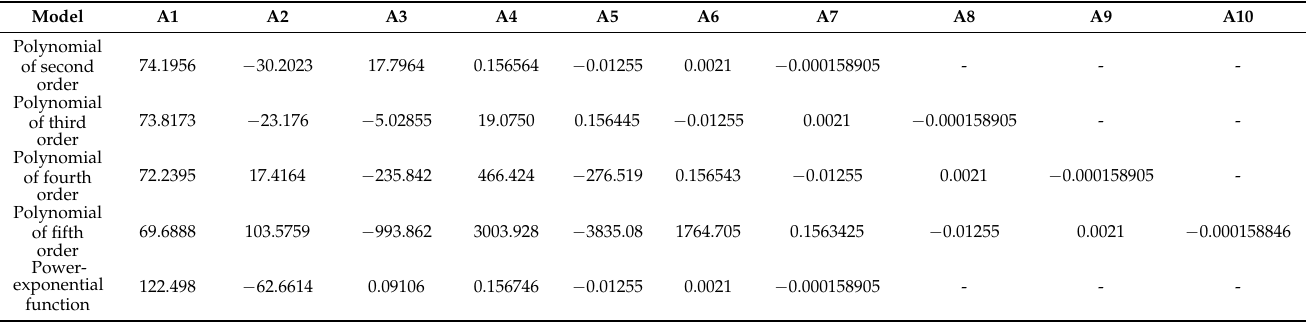
Table 1. The modified Johnson–Cook constitutive model